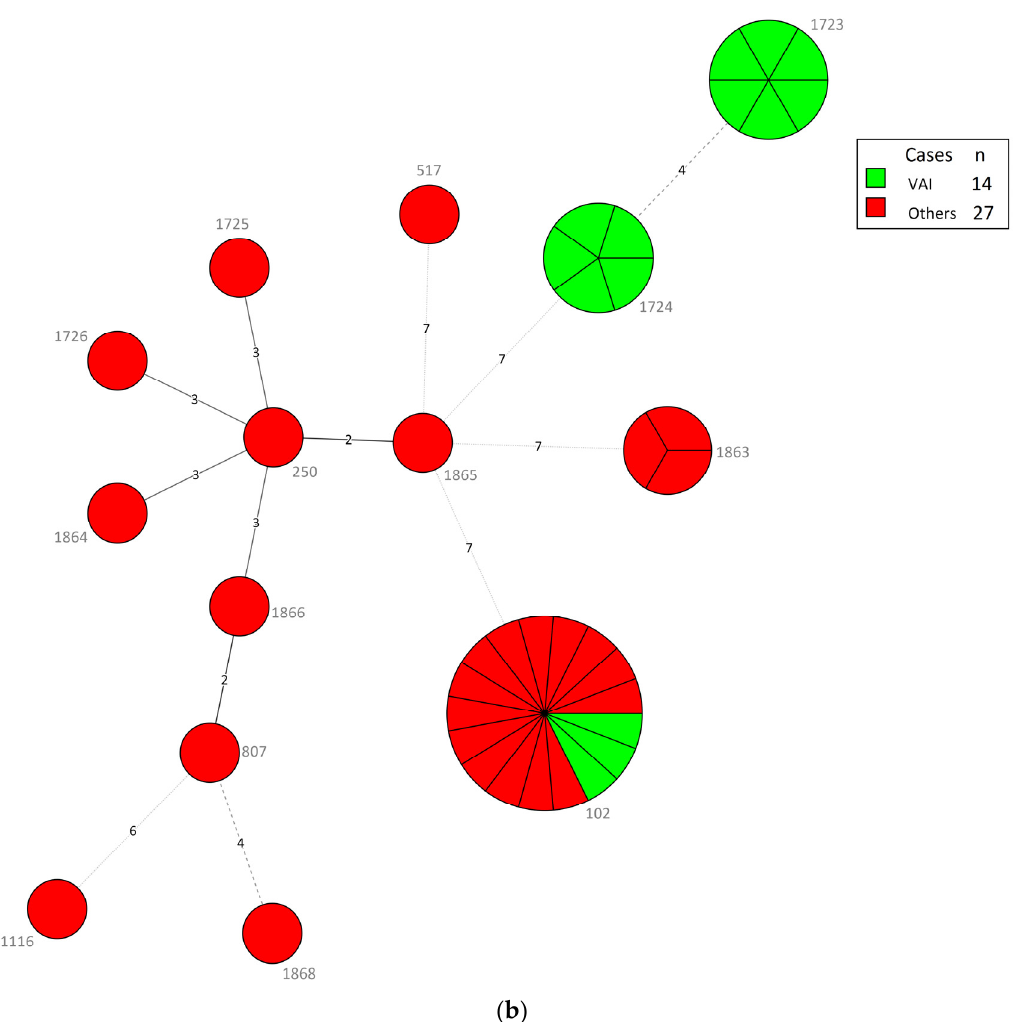
Figure 3. ( a ) Minimum spanning tree (MST) constructed with multilocus sequence typing (MLST), using BioNumerics version 7.6, of the 41 Burkholderia cepacia complex (BCC) isolates consisting of different species. Each node within the tree corresponds to a single sequence type (ST). The ST number is labeled next to the node. Each color inside the nodes represents the species of BCC. The size of the node is proportional to the number of isolates found with that profile. The length of branches between each node indicates the number of alleles (out of seven MLST genes) differing between two linked nodes/ST. ( b ) MST analysis of 41 BCC isolates depending on types of cases (i.e., vascular access infections (VAIs) and other clinical infections). Each color inside the nodes represents the types of cases.